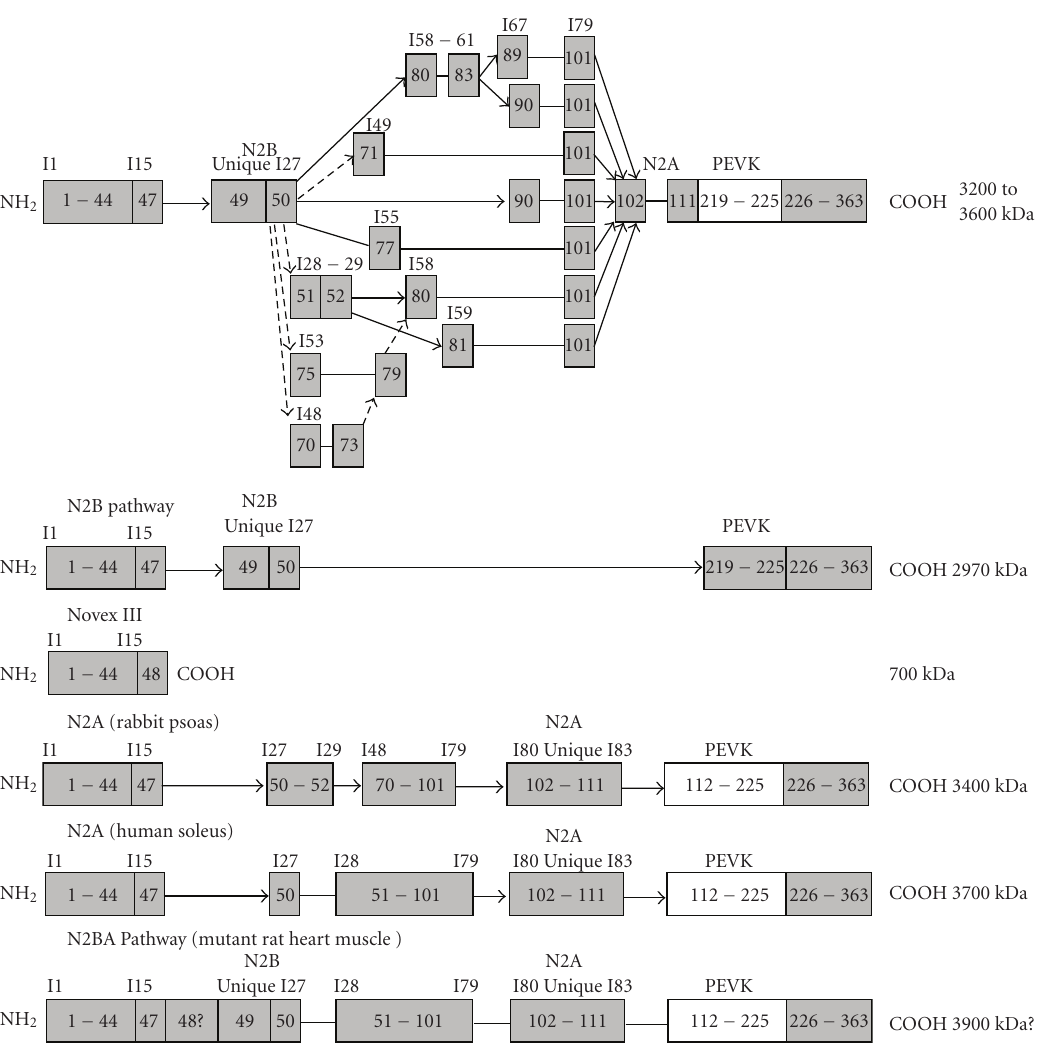
Figure 2: Domain arrangement of di ff erent titin isoforms. Arrows indicate the exons spliced, solid line connections denote consecutive exons. Cross-hatch pattern in PEVK indicates variable patterns of skipped